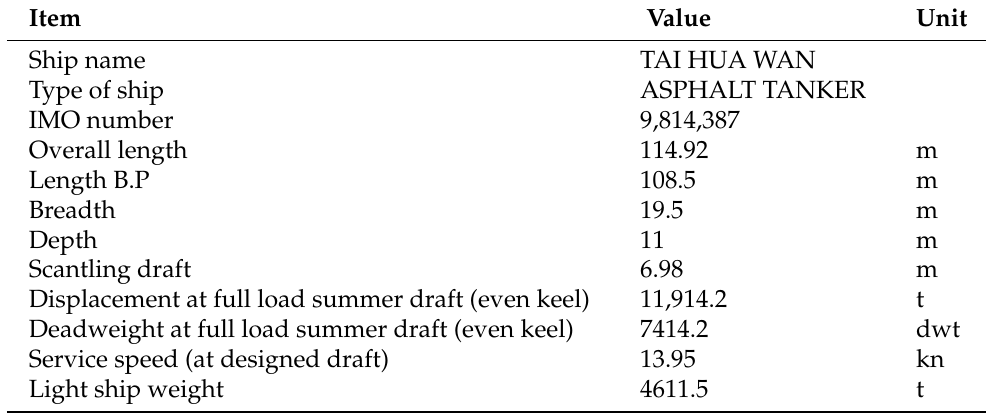
Table 3. Principal parameters of the tanker “TAI HUA